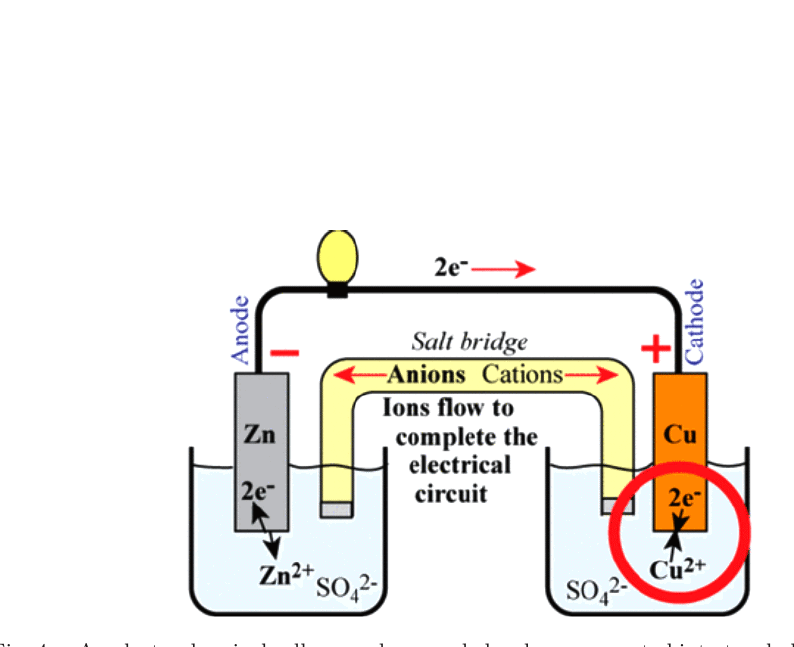
Fig. 4. – An electrochemical cell —a redox couple has been separated into two half-cell reactions, in this case the couple Cu (cid:2) Cu 2+ and Zn (cid:2) Zn 2+ . Figure adapted with permission from